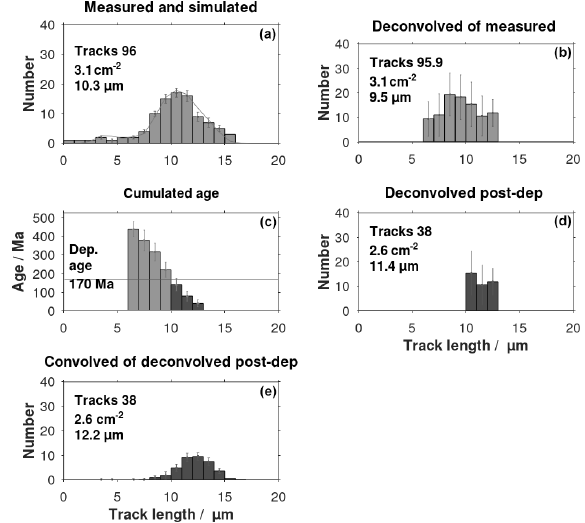
Figure 5. Extraction of the post-sedimentary part of a track length histogram from Jameson Land, East Greenland (Hansen, 1996). The surface track density is given in units of per square centimetre Panel (a) shows the measured and simulated (thin line) fission-track length histogram, and panel (b) shows the histogram after deconvo- lution using the filters shown in Appendix B. (c) The ages of the corrected track are calculated by Eq. (44) using the deconvolved histogram. The columns (dark grey) with ages of corrected tracks that are less than the deposition age (170Ma) are identified. (d) The post-sedimentary histogram is extracted from the deconvolved his- togram based on the identified post-depositional columns. This his- togram is the basis for the direct calculation of the temperature his- tory (Jensen et al., 1992). (e) The convolved post-sedimentary his- togram, resembling a measured histogram, can be used by Monte Carlo-type simulation models (Ketcham, 2005; Gallagher,